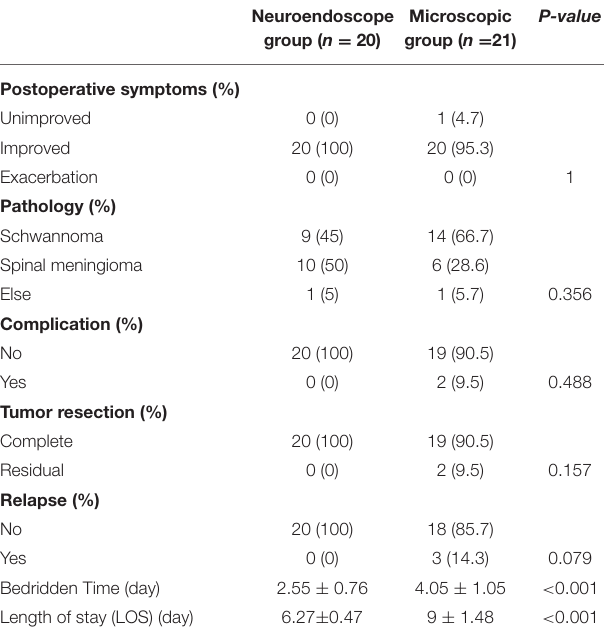
TABLE 4 | Comparison of baseline efficacy and safety indexes in the UHMV and UHNV groups.